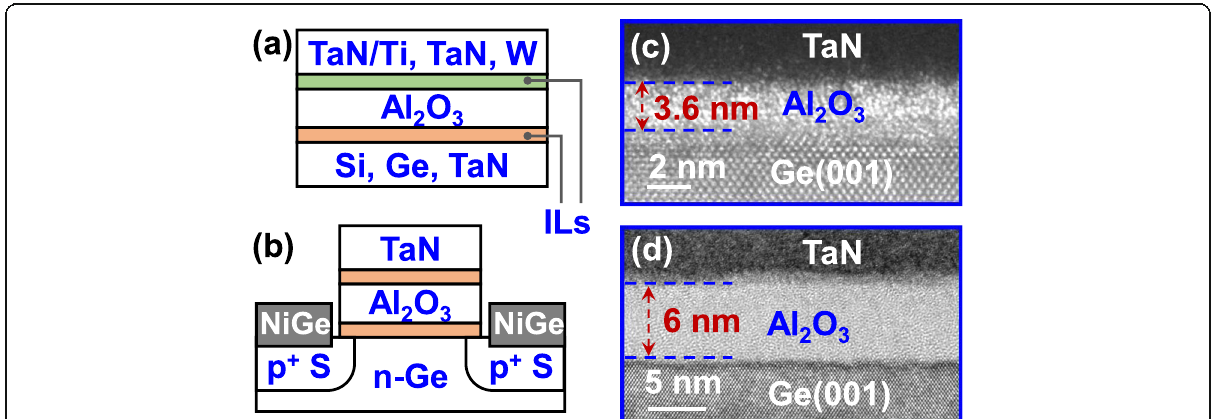
Fig. 1 Schematics of the fabricated a Al 2 O 3 capacitors with various electrodes and b Al 2 O 3 NVFET. c and d HRTEM images of the fabricated TaN/ Al 2 O 3 /Ge stacks with different t AlO , showing the amorphous Al 2 O 3 films after an RTA at 350